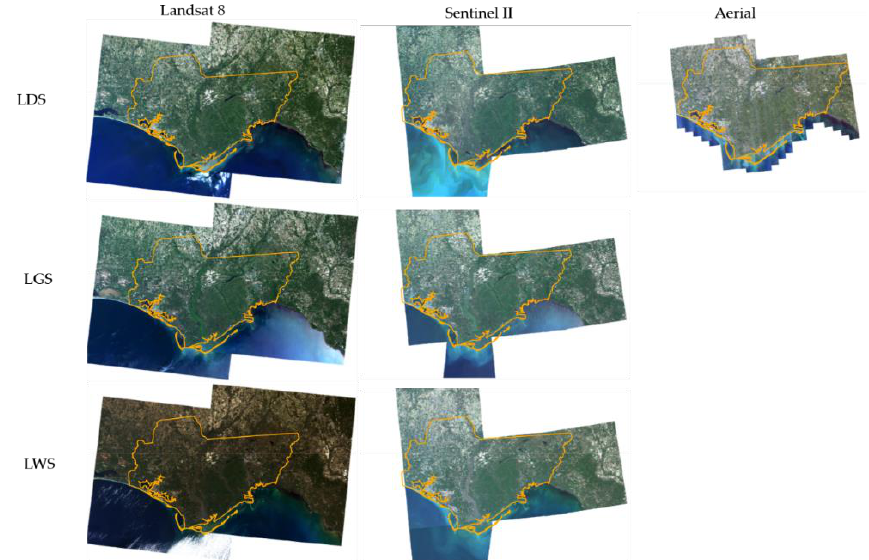
Figure 5. Landsat 8, Sentinel 2, and Aerial true color mosaics for leaf on fall dormant (LDS), leaf on spring growing (LGS), and leaf off winter (LWS) seasons following EANR radiometric scaling. The AGSA boundary is outlined in orange.